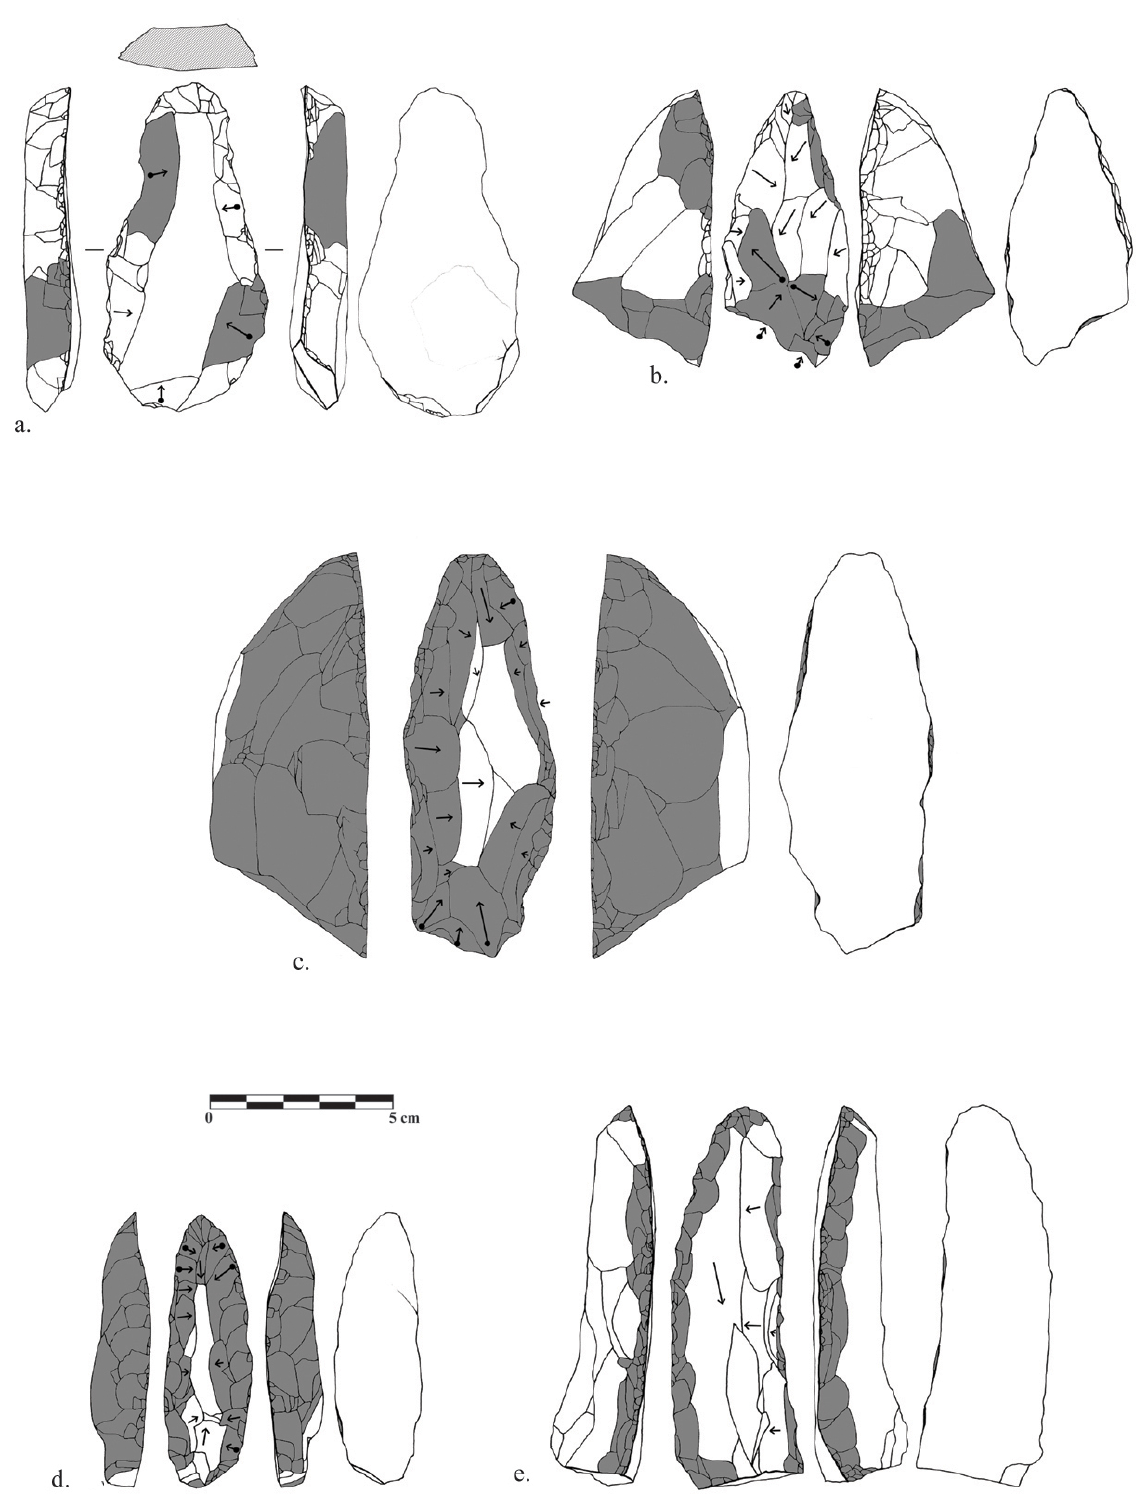
Figure 9. Exemples de pièces présentant des doubles patines attestant d’opérations de réaménagement. En gris : les négatifs présentant une patine récente. Figure 9. Examples of artefacts with double patinas arising from reconfigurations. In grey: removals with a recent